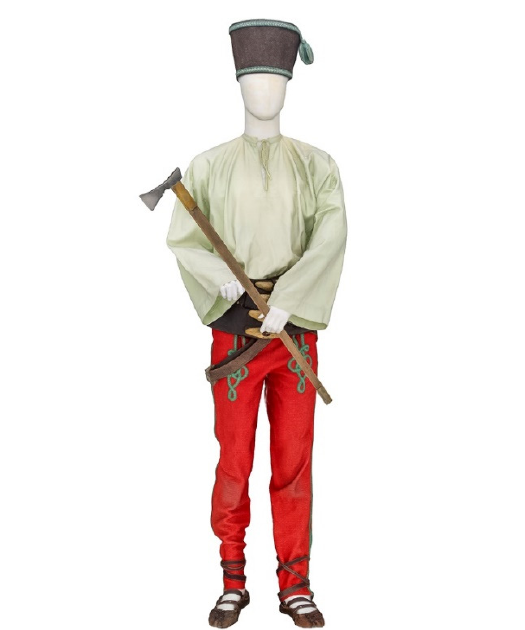
Figure 4. 3D model of a folk costume (2 models merged)